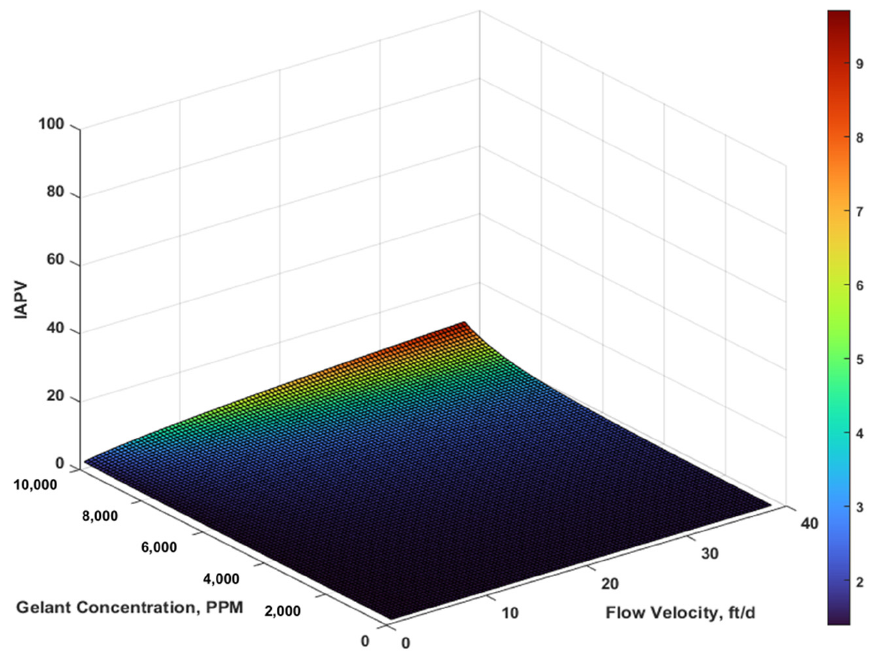
Figure 9. Combined effect on fracture IAPV in fracture in percentage.